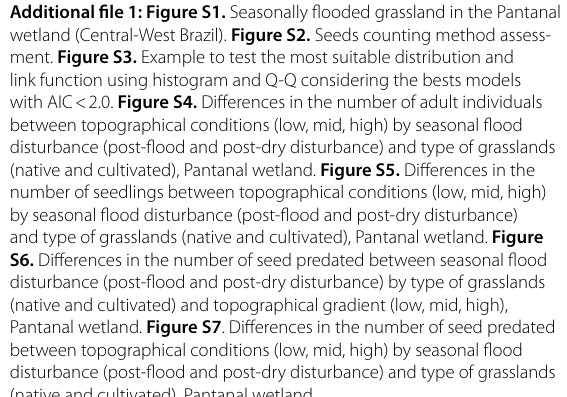
ment. Figure S3. Example to test the most suitable distribution and link function using histogram and Q-Q considering the bests models with AIC < 2.0. Figure S4. Differences in the number of adult individuals between topographical conditions (low, mid, high) by seasonal flood disturbance (post-flood and post-dry disturbance) and type of grasslands (native and cultivated), Pantanal wetland. Figure S5. Differences in the number of seedlings between topographical conditions (low, mid, high) by seasonal flood disturbance (post-flood and post-dry disturbance) and type of grasslands (native and cultivated), Pantanal wetland. Figure S6. Differences in the number of seed predated between seasonal flood disturbance (post-flood and post-dry disturbance) by type of grasslands (native and cultivated) and topographical gradient (low, mid, high), Pantanal wetland. Figure S7 . Differences in the number of seed predated between topographical conditions (low, mid, high) by seasonal flood disturbance (post-flood and post-dry disturbance) and type of grasslands (native and cultivated), Pantanal wetland.